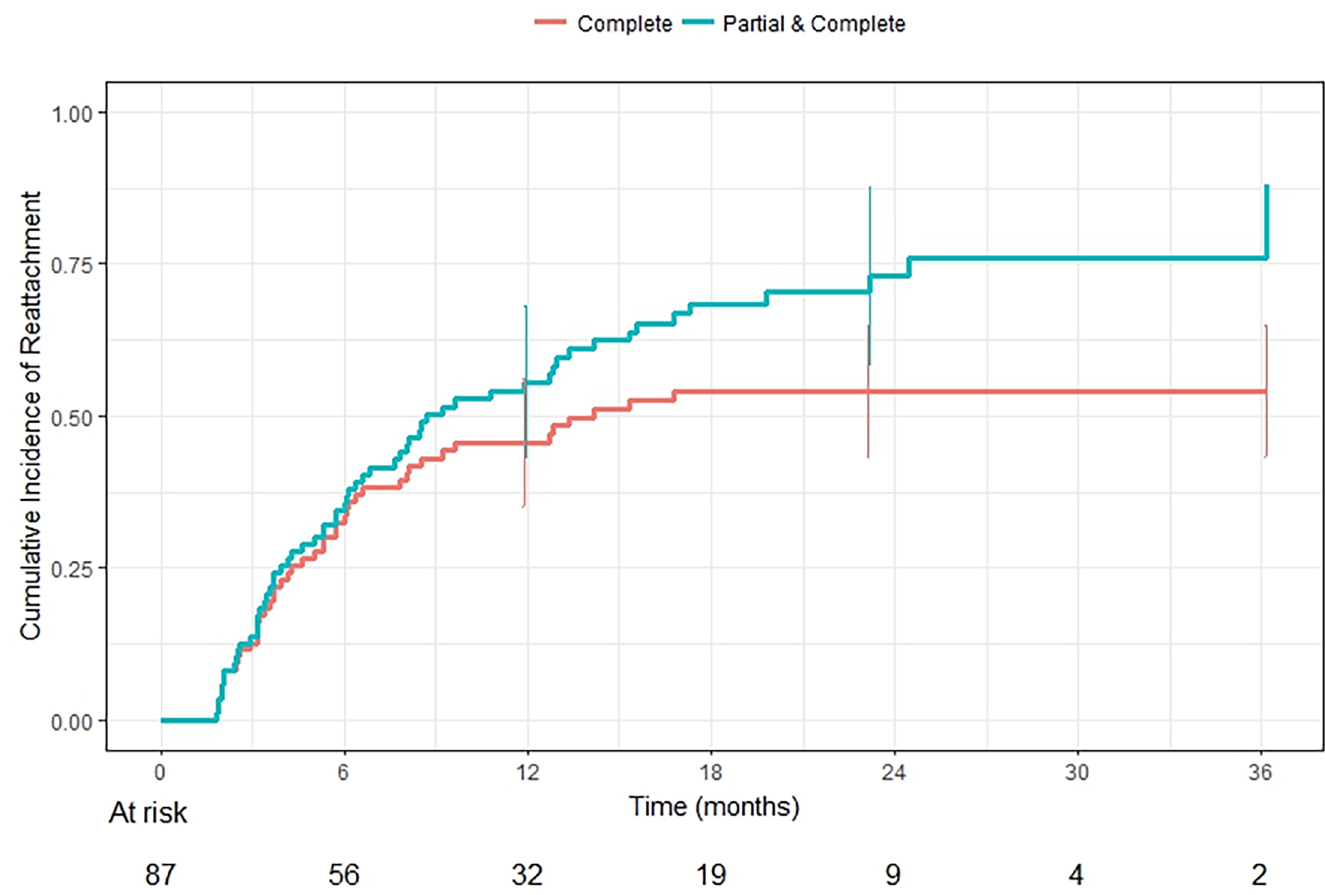
Fig 2. Cumulative incidence of retinal reattachment by time